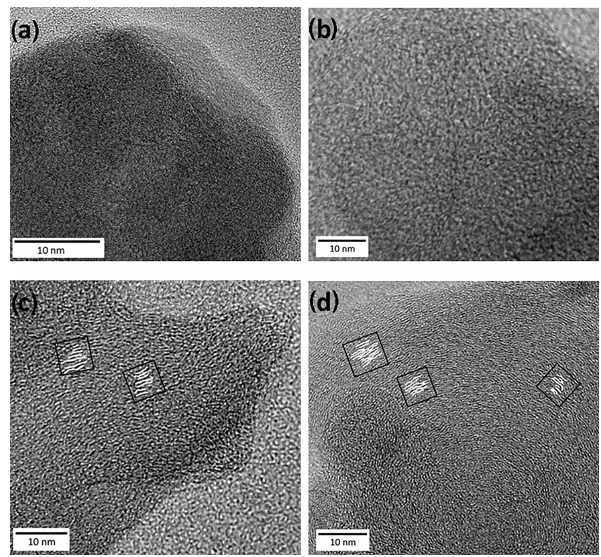
Figure 7. High-resolution TEM image of individual refractory car- bonaceous particles from sample G (17.4km altitude): (a, b) com- pletely amorphous particles and (c, d) particles showing small re- gions with ordering. Table 4. Graphene sheet separation